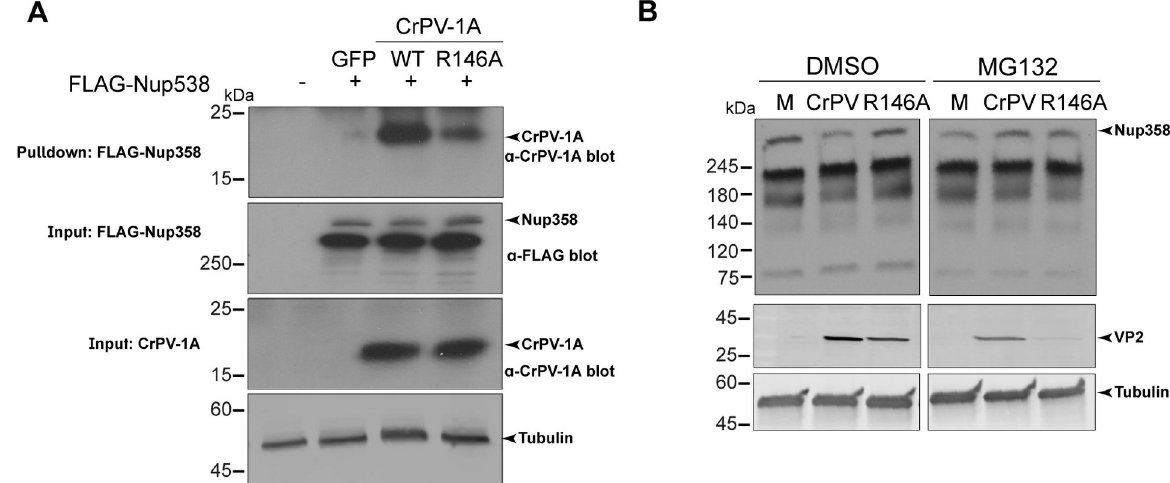
Fig 9. Nup358 is degraded during CrPV infection. (A) Co-immunoprecipitation assay of S2 cells transiently transfected with FLAG-Nup358 for 24 hours, then transfected with either GFP, CrPV-1A, or CrPV-1A(R146A) RNA for 16 hours. Lysates were incubated with FLAG antibody as bait and precipitated using Protein A/G Magnetic beads. Shown are representative immunoblots from three independent experiments. (B) Immunoblots of S2 cell lysates infected with (M) mock, CrPV or CrPV(R146A) (MOI 1) in the presence or absence of DMSO or 50 μ M MG132. Shown are representative immunoblots from three independent